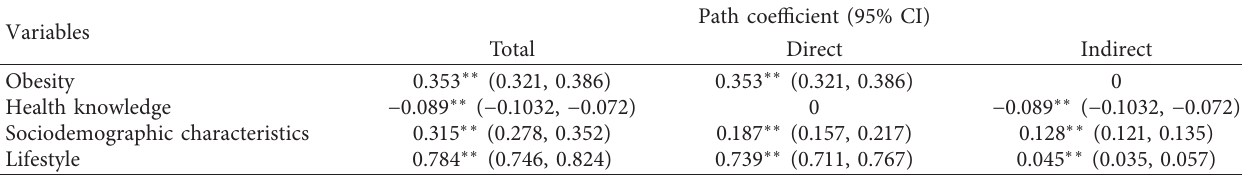
Table 3: Direct and indirect effects of obesity, lifestyle, health knowledge, and sociodemographic characteristics on CDH.